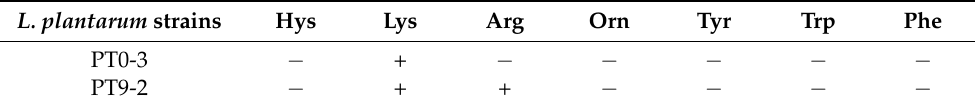
Table 3. Amino acid decarboxylase activity test results of L. plantarum strains.